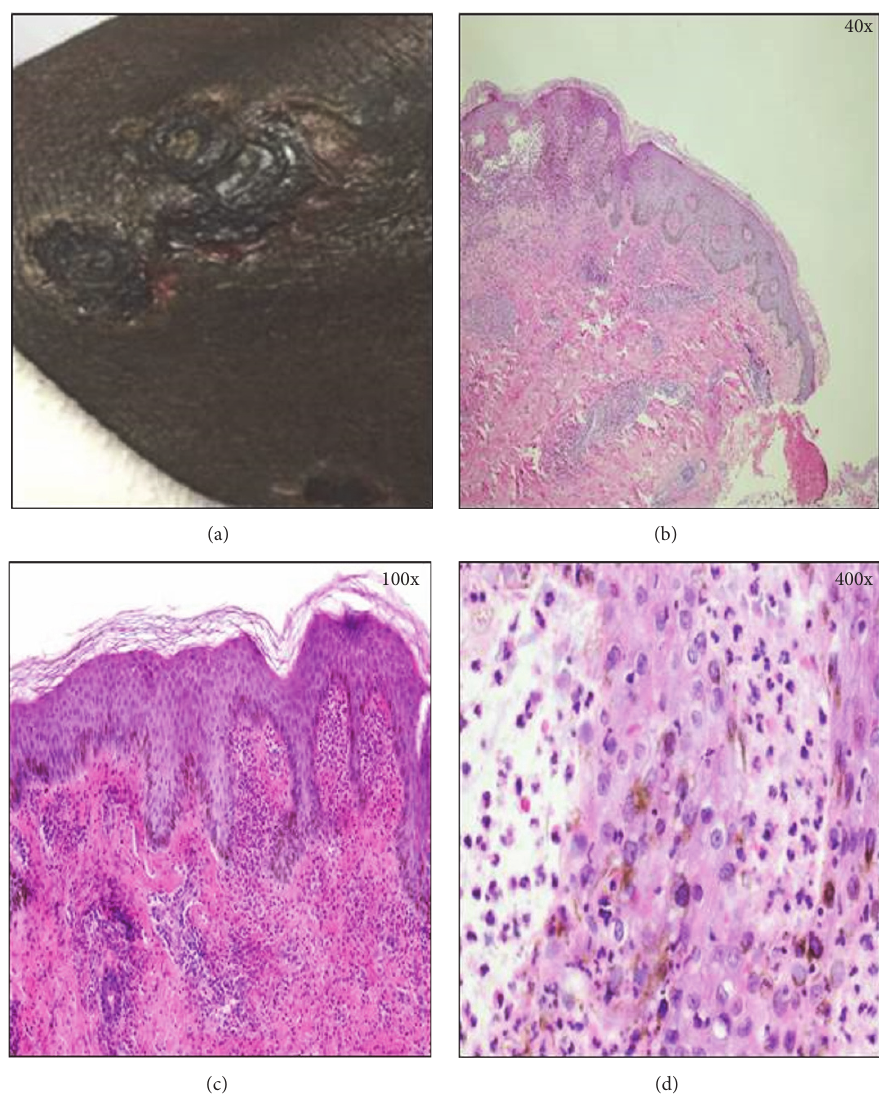
Figure 1: Clinical picture of the bullous lesion along with histopathologic examination of the biopsy specimen. (a) Picture showing bullous lesion on the surface of skin. (b) Histopathologic examination of the specimen shows a punch biopsy specimen Haematoxylin and Eosin (H&E) stain at 40x. Subepidermal vesicle formation is seen with inflammatory infiltrate in the vesicular space. (c) H&E stained specimen at 100x Basket weave stratum cornea is seen overlying epidermis with some exocytosis of neutrophils. (d) H&E staining at 400x. Within the papillary dermis a perivascular infiltrate of neutrophils and lymphocytes with occasional eosinophils is